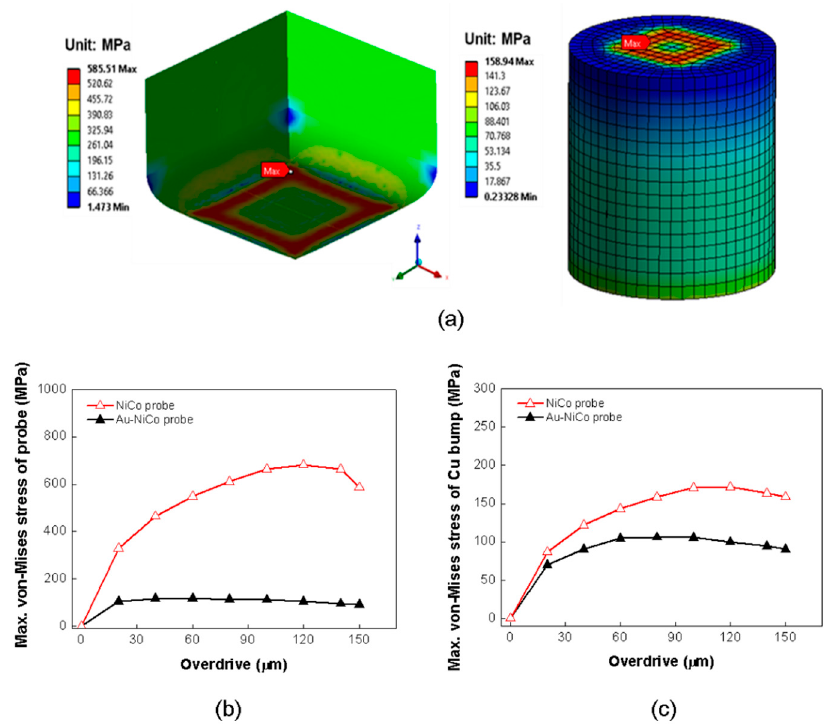
Figure 10. ( a ) Stress distribution map of the NiCo probe and Cu microbump at an overdrive of 150 µm. ( b ) The variation in the maximum stress generated in the probe for different overdrives. ( c ) The variation in the maximum stress of the Cu microbump for different overdrives.